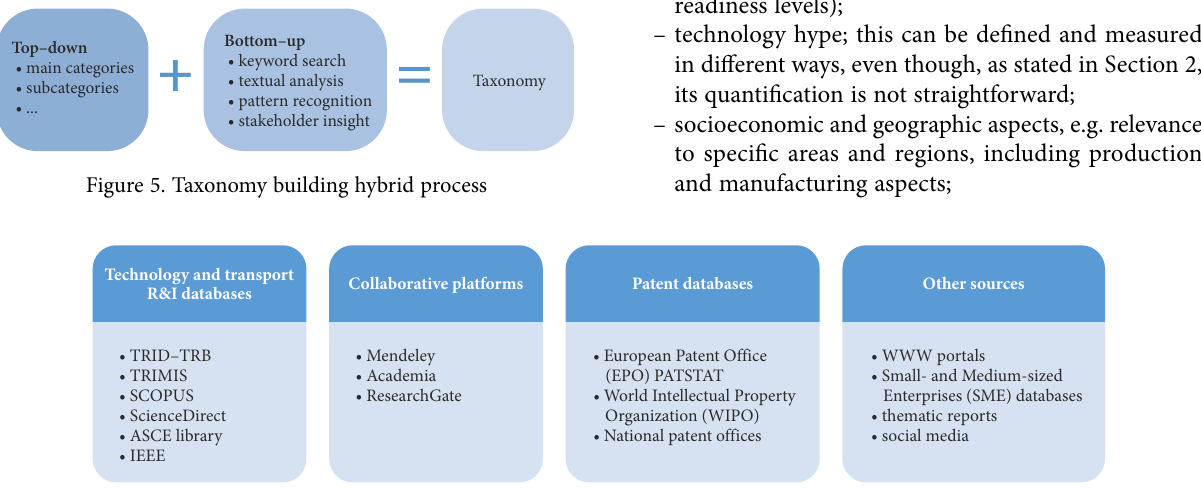
Figure 6. Overview of taxonomy building